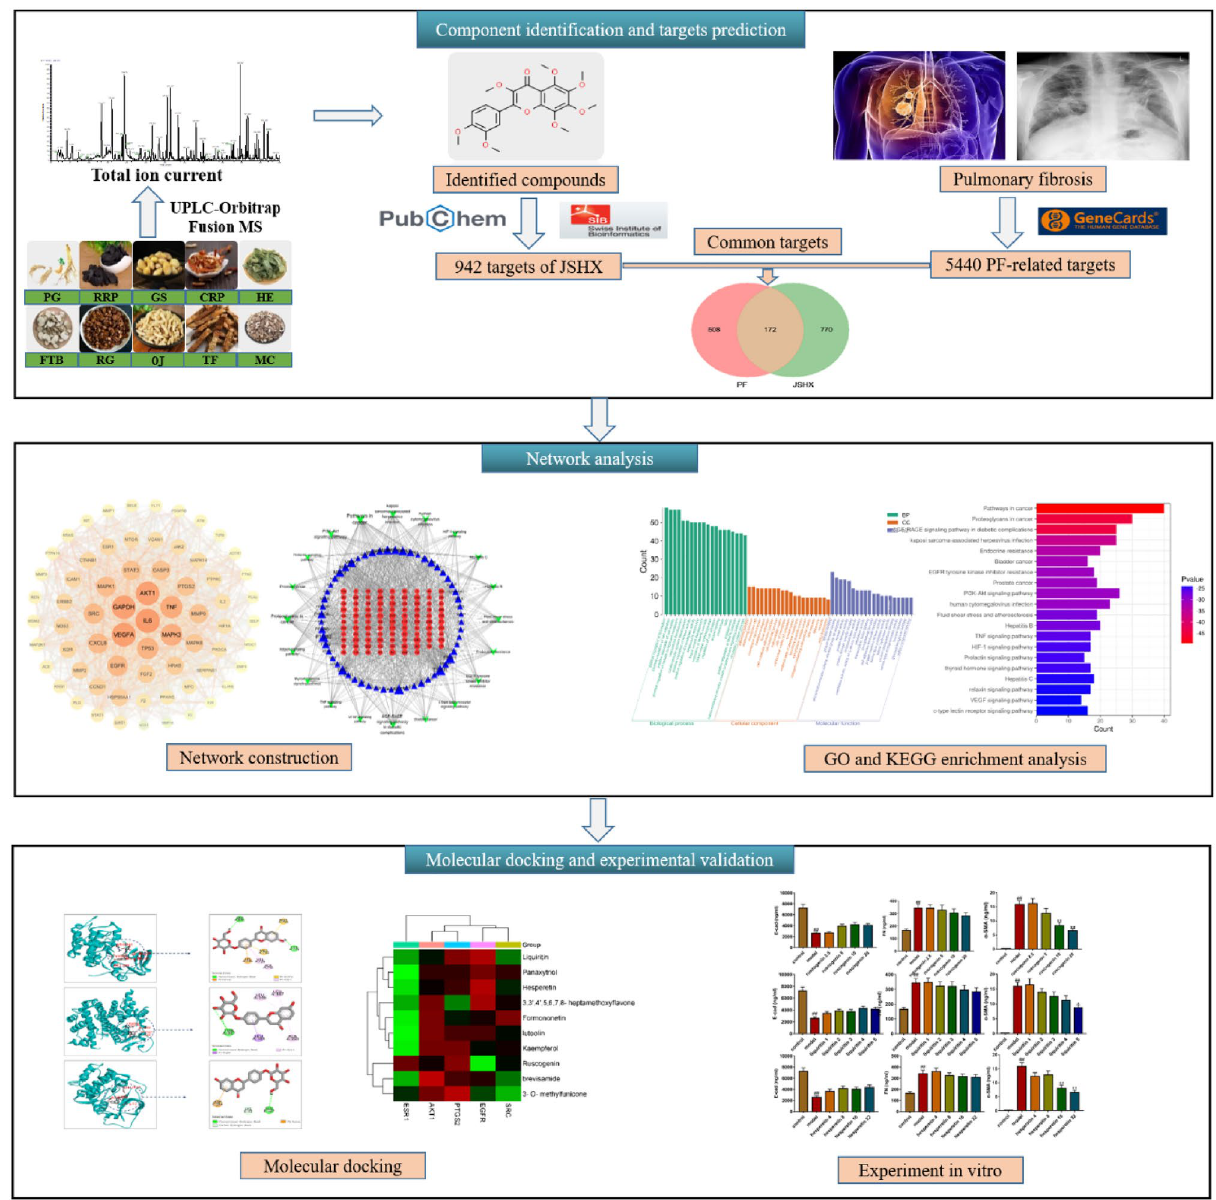
Figure 1. The whole framework based on an integration strategy of UPLC-Orbitrap Fusion MS integrated with network pharmacology, molecular docking and experiment in